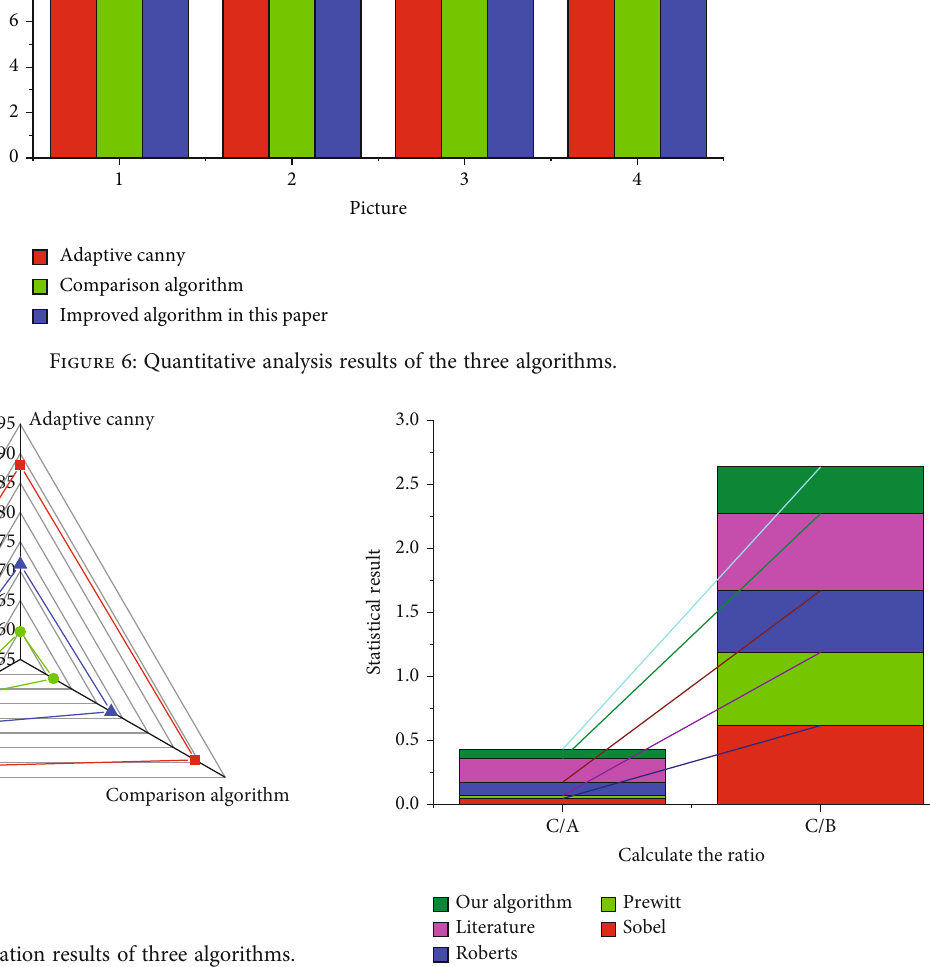
Figure 8: Statistical results of edge